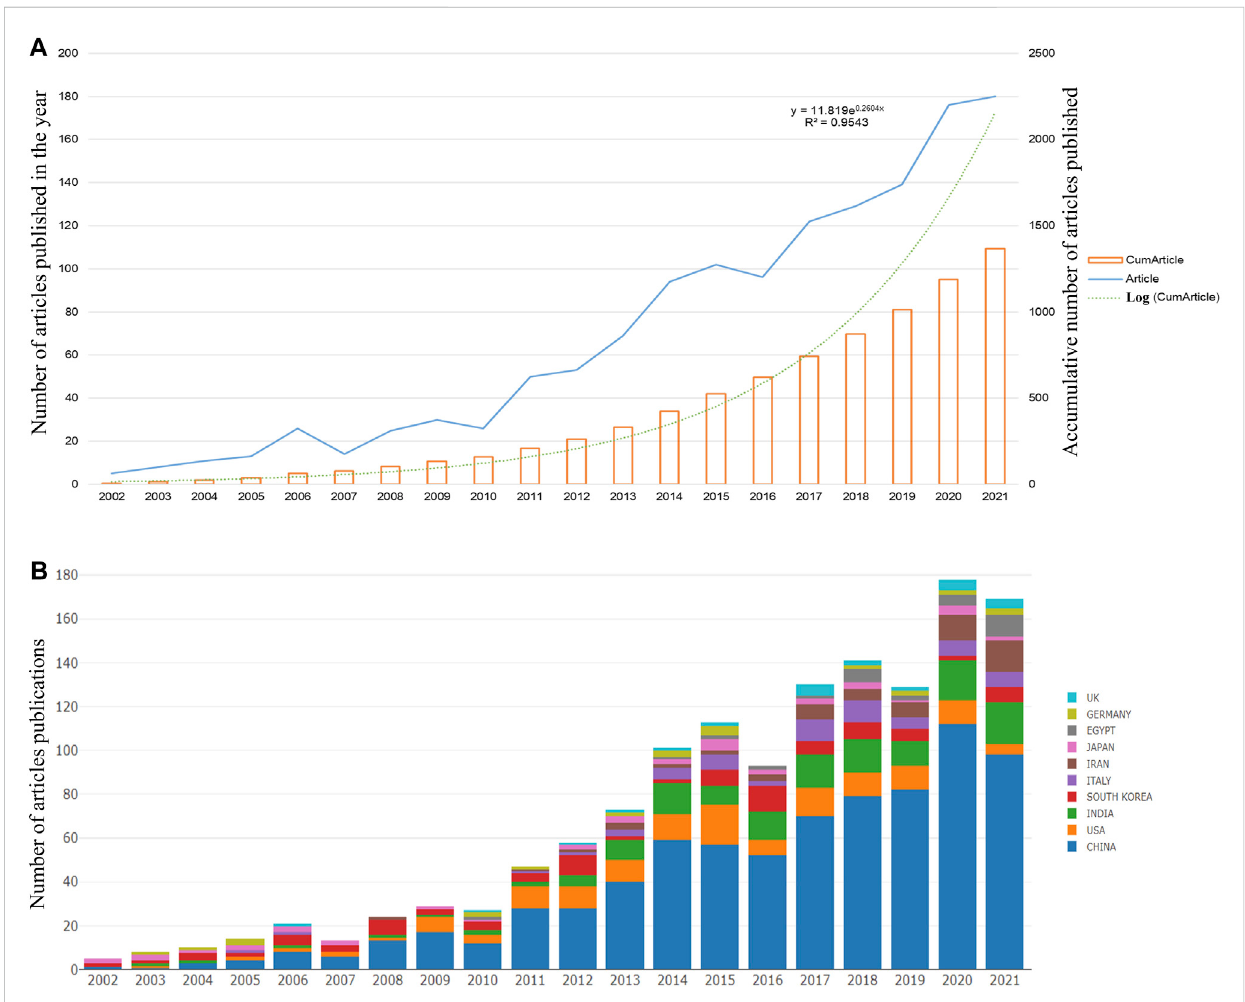
FIGURE 2 Global trends of publications about berberine and tumor. (A) The number of articles published each year and the accumulative number of articles from 2002 to 2021. (B) The annual number of papers published by nations from 2002 to 2021.